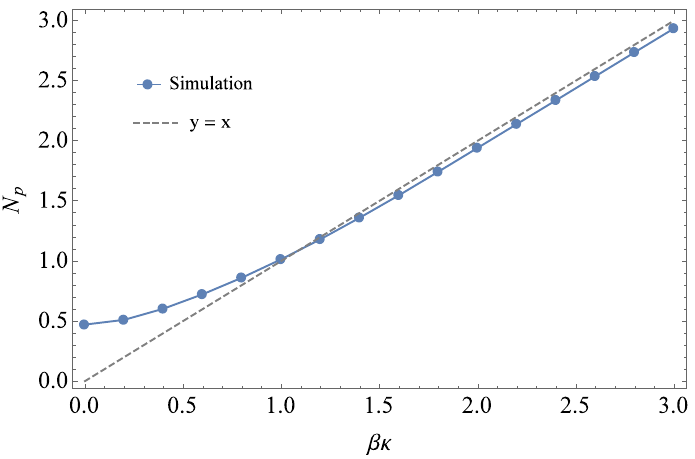
Figure 2. N p (in beads) determined from the simulation for pure systems with βκ ranging from 0 to 3. Results show that for βκ > 1, N p ≈ βκ